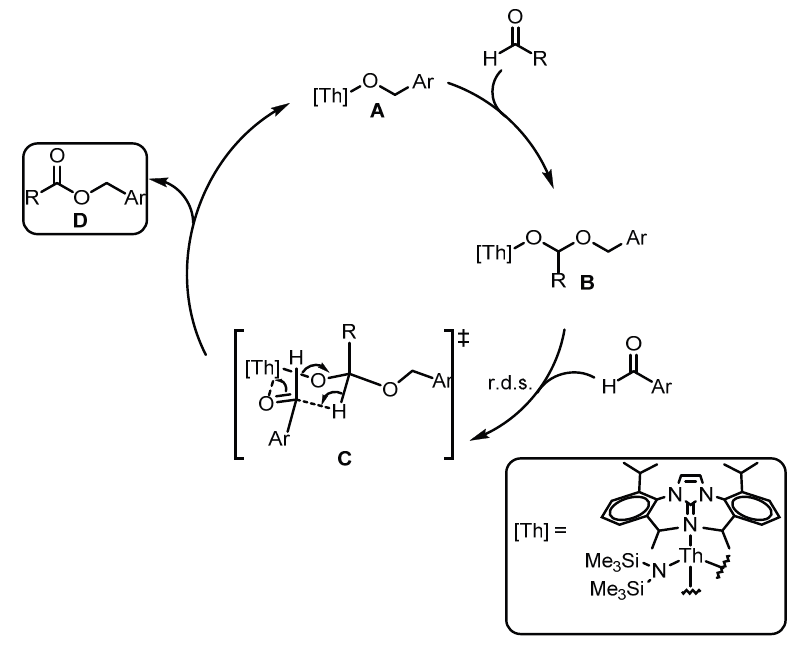
Scheme 17. Mechanism for the crossed Tishchenko reaction mediated by (Im Dipp N)Th(N(SiMe 3 ) 2 ) 3 ( 15 ). Adapted with permission from Karmel, I.S.R.; Fridman, N.; Tamm, M.; Eisen, M.S. J. Am. Chem. Soc. 2014 , 136 , 17180–17192 [75]. Copyright 2014 American Chemical